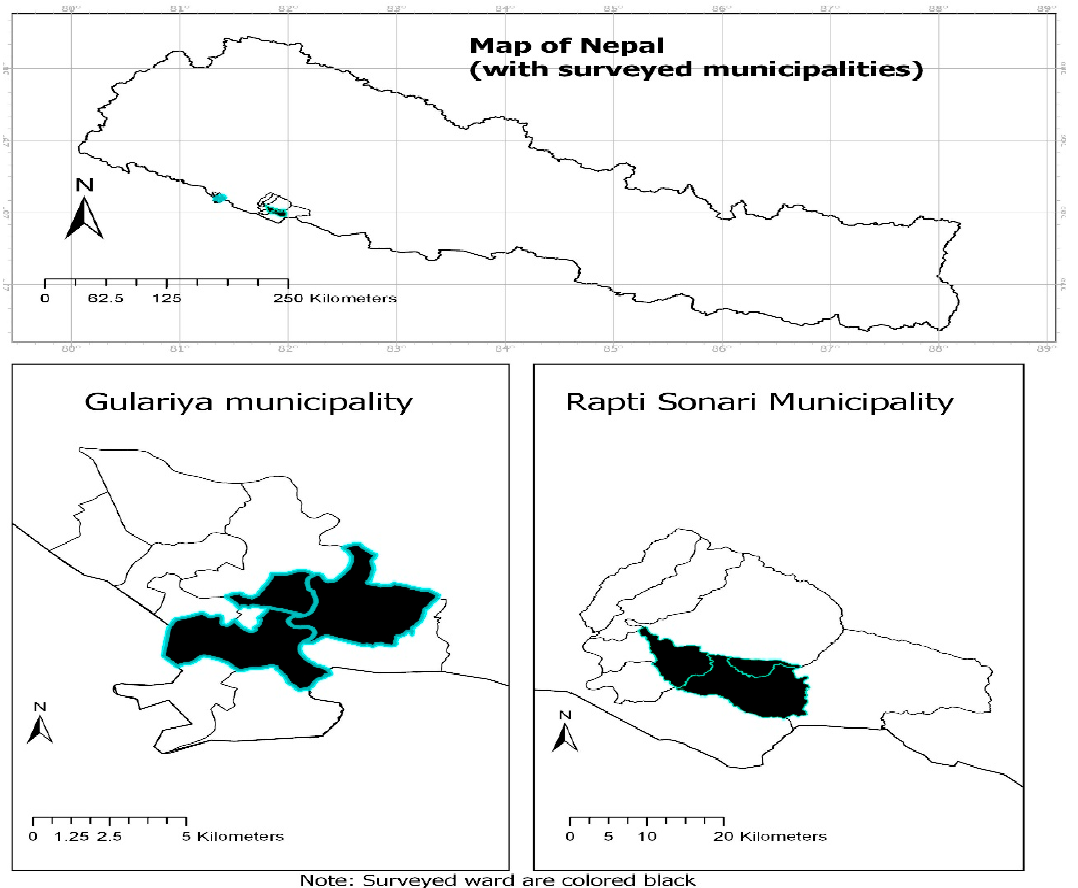
Figure 1. Study Figure 1. Study areas.